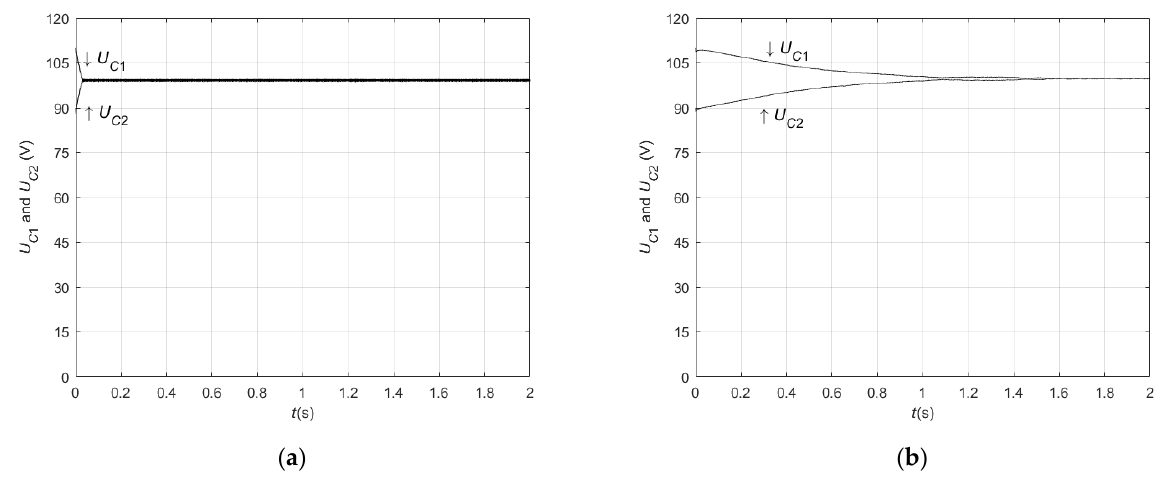
Figure 7. Simulation results comparison in steady state, of the capacitor voltage U C 1 and U C 2 using: ( a ) backstepping predictive and ( b ) backstepping with PWM.